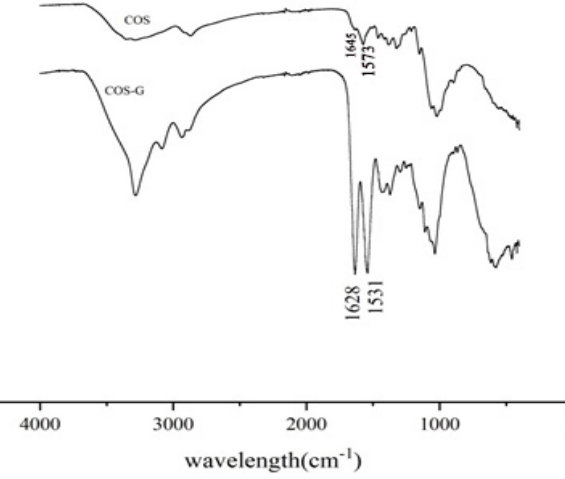
Figure 1. Infrared spectra of COS and COS ‐ G.